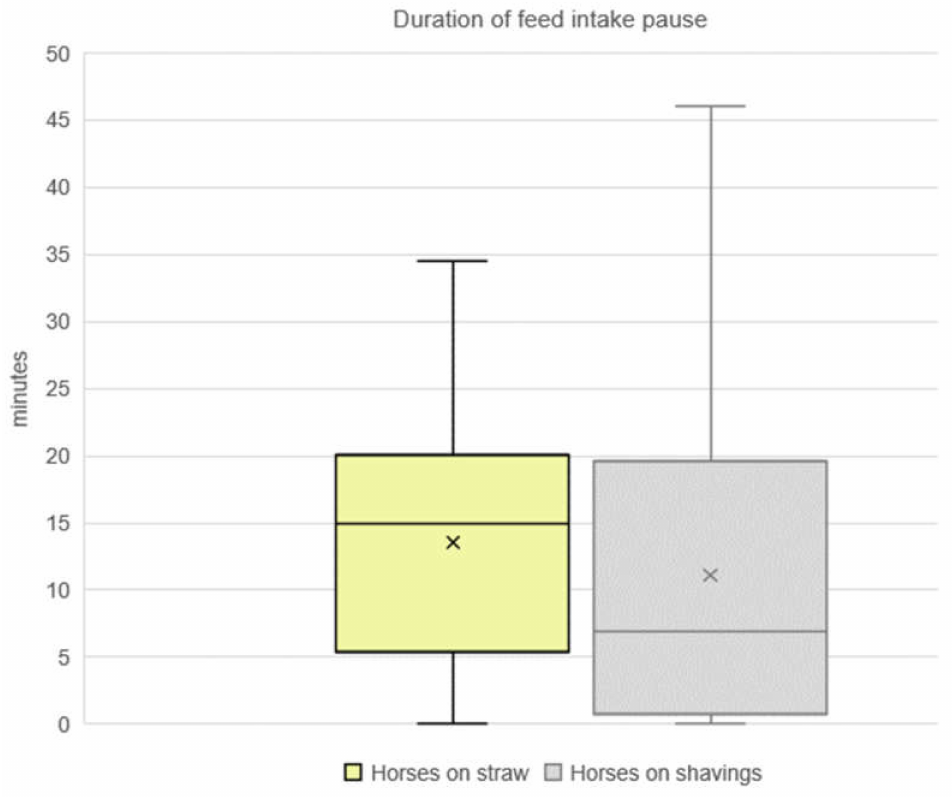
Figure 4. Duration of feed intake pause during the evening meal of horses on straw compared to horses on shavings (feed of hay or a mix of hay and straw to n = 55 horses; median: 15 min of n = 25 horses on straw; median: 7 min of n = 30 horses on shavings, n.s. with p = 0.36) Table 3. Latency from the start of the evening feeding until the first pause divided into three categories according to the duration of the feed intake pauses (mean ± SEM, in minutes) and frequency of pauses per each category for horses on straw and shavings (in